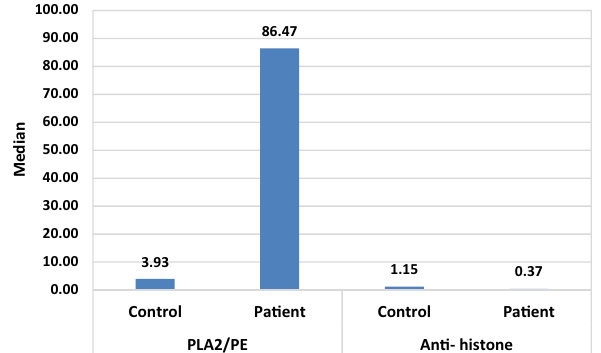
Figure 2. Median of PLA2/PE and anti histone for each goup.